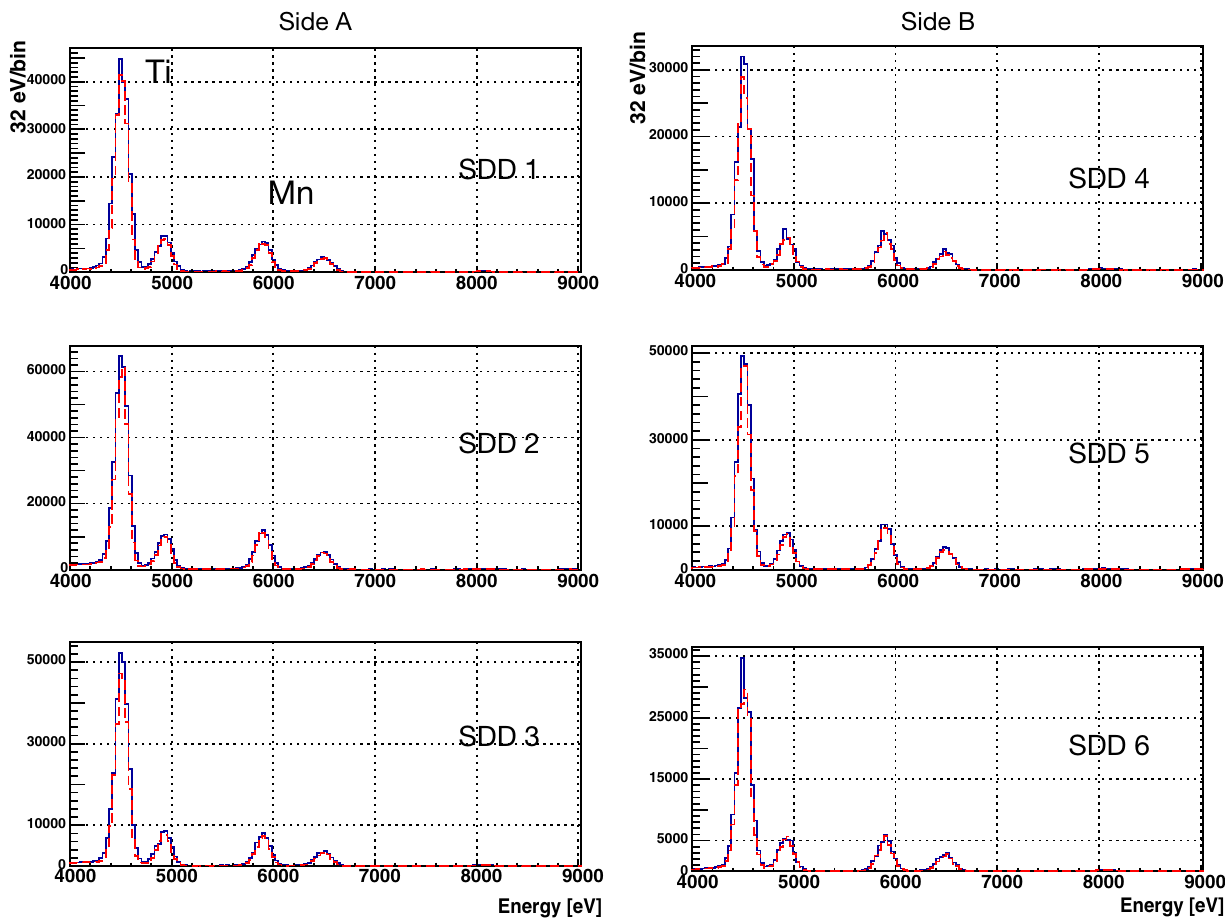
Fig. 7 The energy spectra of six individual SDD units; data taking with current: dashed lines; data taking without current: solid lines. Copper lines are not visible with a linear vertical axis scale. All spectra are in their full statistics without normalization with exposure time nent that corresponds to the PEP violating candidate